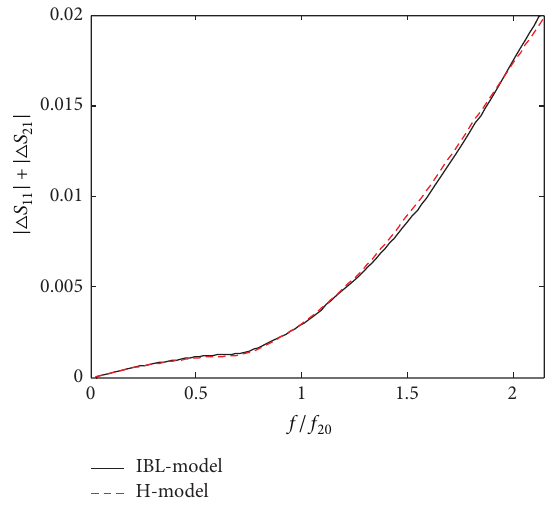
Figure 8: The 𝑆 -parameter differences at 𝜃 0 = 60 ∘ for the H- and IBL-models with parameters retrieved at normal incidence.